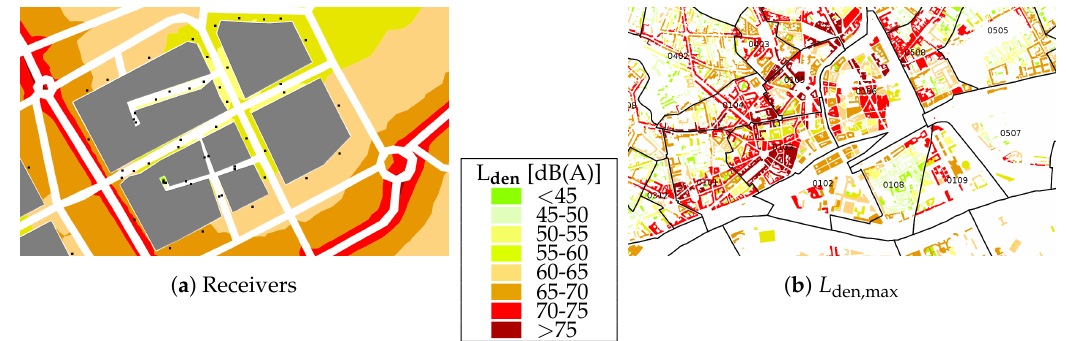
Figure 13. Illustrations of: ( a ) the front facade receivers (black points); and ( b ) the cartography of the maximal equivalent sound levels L den,max per buildings for the 2008 reference year situation (T0).